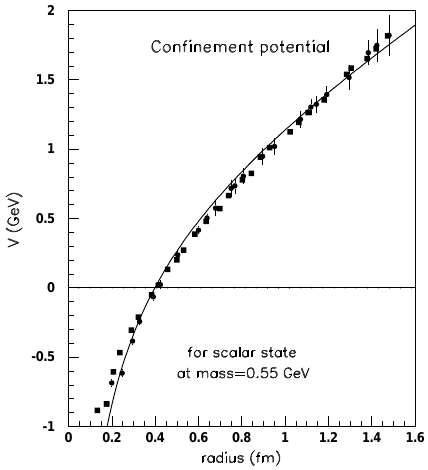
Fig. 2. Deduced ’confinement’ potential V 2 g ( r ) in comparison with lattice gauge simulations [5] (solid